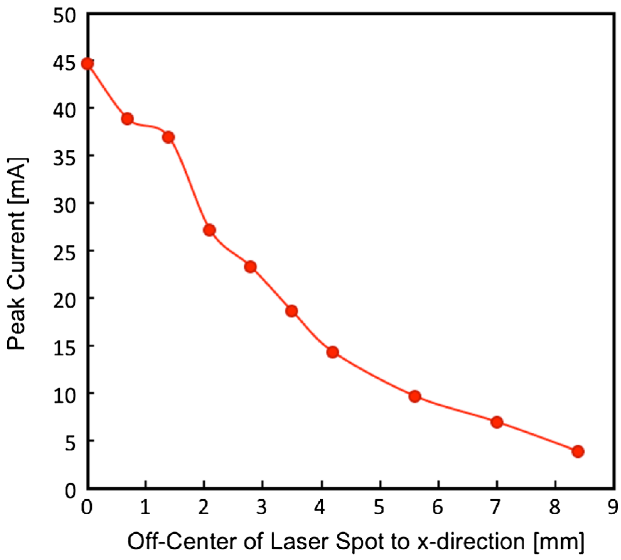
FIG. 35. Relationship between output beam current from chan- nel 1 and laser irradiated point on the carbon target (pickup voltage: 5.2 V; plasma input position: 6 mm; extraction voltage: 30 kV).